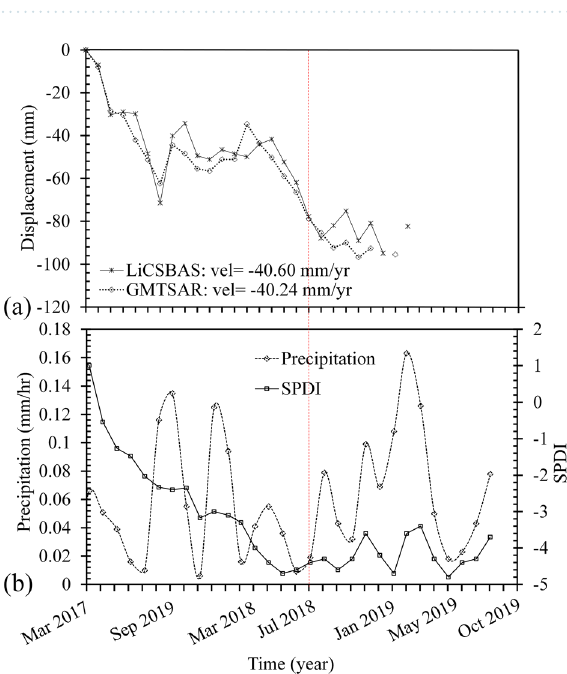
Figure 15. LOS displacement time series from S1A images (March 2017 to January 2019) for ( a ) A-101 track, ( b ) D-6 track, and correlation between the results of GMTSAR and LiCSBAS for ( c ) A-101 track, ( d ) D-6 track.